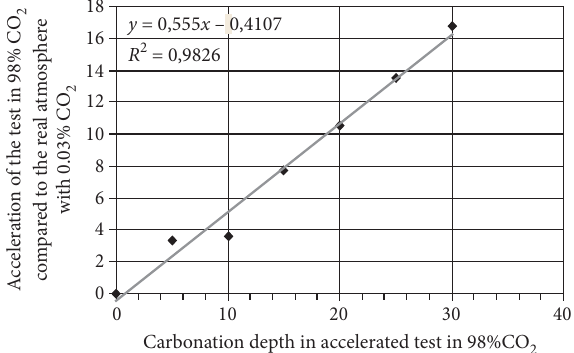
Fig. 4. Acceleration of the carbonation depth test in 98% CO